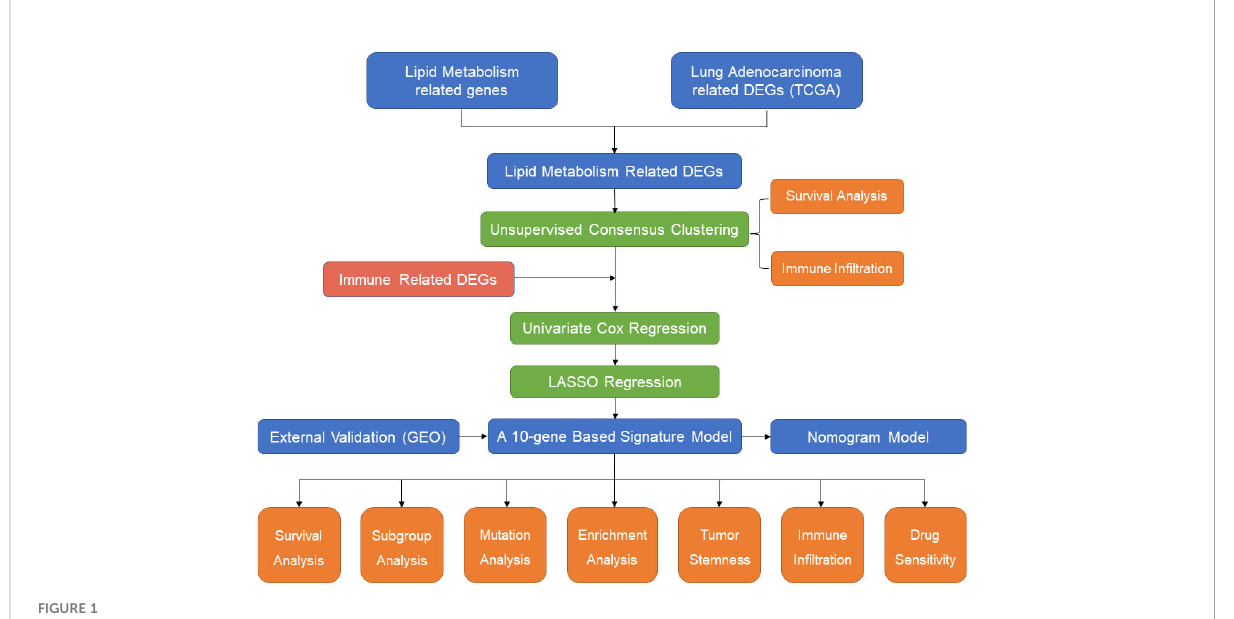
FIGURE 1 The fl ow diagram of the present